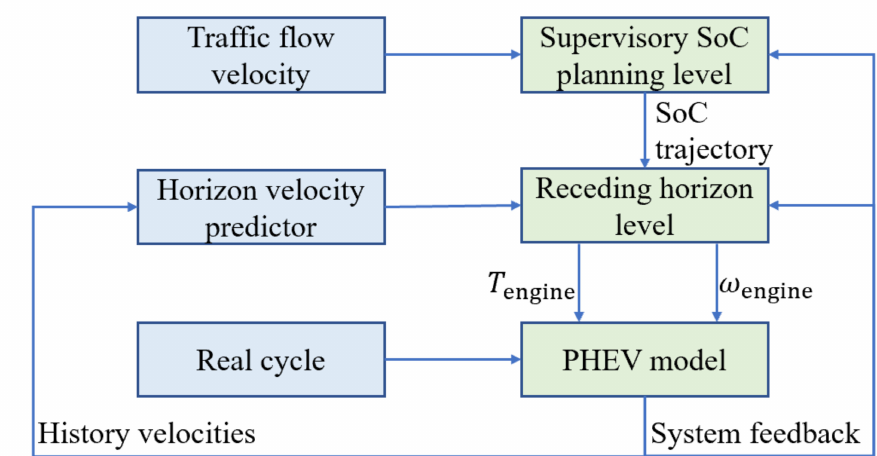
Figure 19. Schematic diagram of hierarchical predictive energy management.